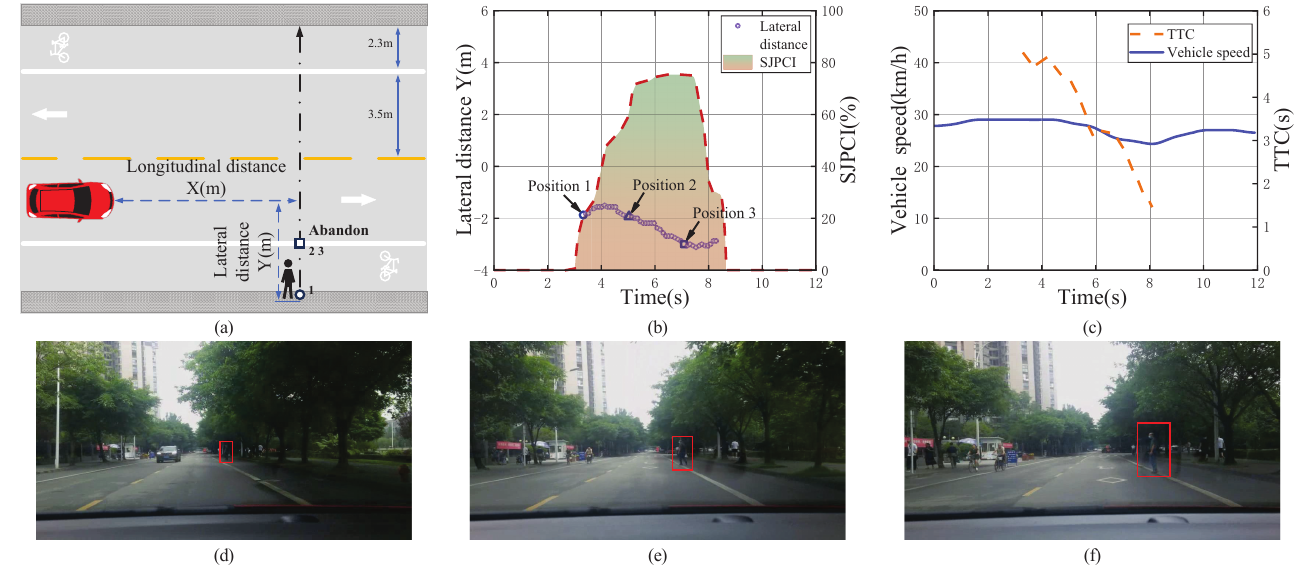
Figure 7. A mild deceleration event when encountering a pedestrian crossing the street and the data analysis results. ( a ) Pedestrian–vehicle interaction schematic diagram; ( b ) Lateral distance and SJPCI; ( c ) Vehicle speed and TTC; ( d ) Position 1: Pedestrians started crossing from the right lane line; ( e ) Position 2: Pedestrians crossed the right lane line; ( f ) Position 3: Pedestrians gave up crossing the